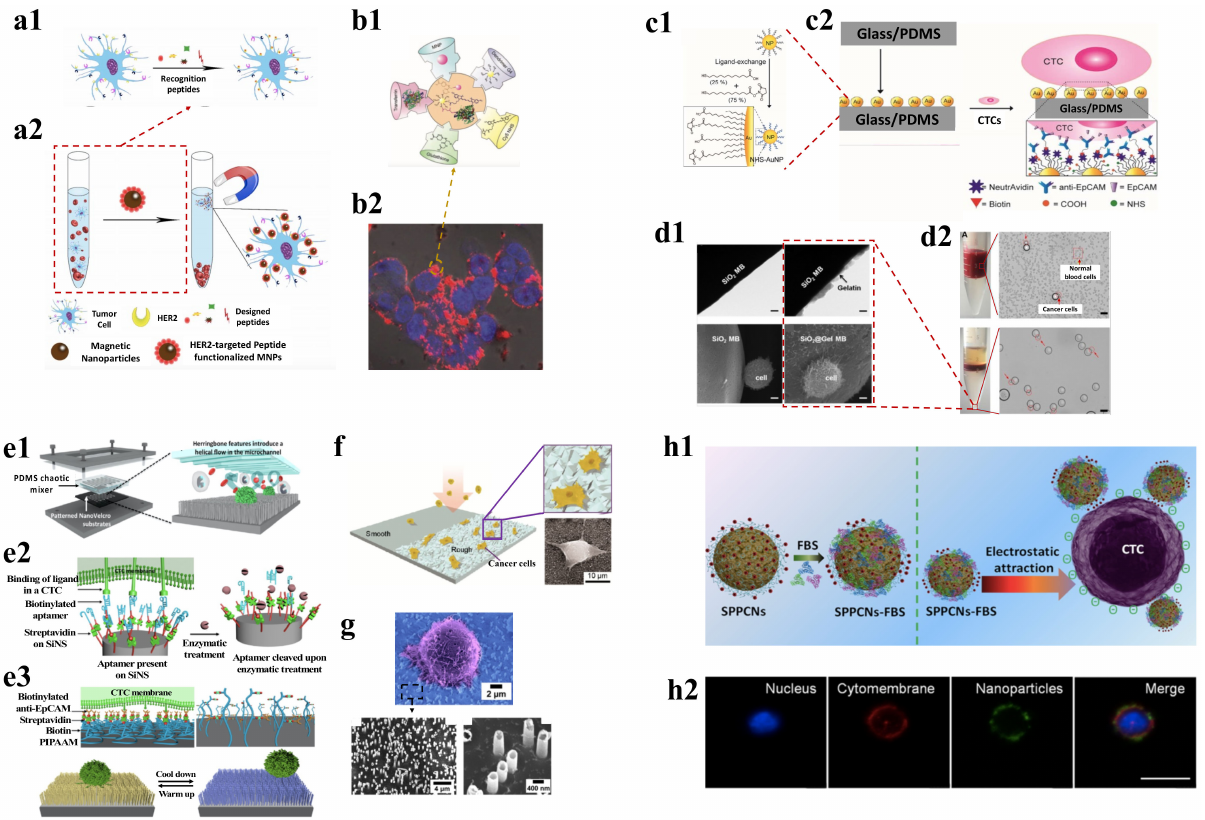
Figure 4. Highlights the different methods for isolation of CTCs using nanoparticles. ( a1 ) Shows the schematic representation of the process that involves tagging ligand conjugated NPs to CTCs. ( a2 ) highlights the capture of the targeted CTCs using an external magnet. Reprinted with permission from [120]. Copyright 2017 American Chemical Society. ( b1 ) shows the different components of the MDNS whereas ( b2 ) demonstrates the effective conjugation of the nanosystem on the surface of the cells (nucleus stained with DAPI appeared blue whereas MDNS appeared as red). Reprinted with permission from [101]. Copyright 2012 John Wiley and Sons. ( c1 ) highlights the preparation of the functionalized NPs by ligand exchange process. ( c2 ) Scheme shows the process of capturing CTCs using AuNPs in Herringbone microfluidic chip. Reprinted with permission from [104]. Copyright 2017 American Chemical Society. ( d1 ) The enlarged SEM image shows the efficient binding of CTCs on the surface of gelatine NPs coated silicon beads separated by Ultra-centrifugation and ( d2 ) represent the microscopic images of the captured cancer by CTC-beads (top panel) and improved selection by density gradient centrifugation (bottom panel); The scale bar is 20 µ m. Reprinted with permission from [106]. Copyright 2018 Ivyspring International Publisher. ( e ) Highlights the different generations of nano-velcro for efficient isolation of CTCs. ( e1 ) represents the first generation in which the Si-nanowire captures the CTCs which flow through the microfluidic device. The second generation of the system as shown in the ( e2 ) panel, is based on enzymatic capture and release of CTCs whereas the third generation (shown in e3 ) uses a thermoresponsive polymer to effectively capture CTCs at 37 ◦ C but releases the cells when the temperature reaches 4 ◦ C. Reprinted with permission from [107]. Copyright 2014 American Chemical Society. ( f ) Shows the nanoroughened glass surface along with the SEM image of cancer cells efficiently captured by it. Reprinted with permission from [122]. Copyright 2013 American Chemical Society. ( g ) Capture of CTCs using nanostraws with the enlarged SEM image of it. Reprinted with permission from [123]. Copyright 2019 American Chemical Society. ( h1 ) shows the process of capturing CTCs by electrically charged NPs, ( h2 ) image panel shows the efficient binding of the positively charged Poly(ethyleneimine)-functionalized Fe 3 O 4 NPs on the outer surface of CTCs due to effect; The scale bar is 20 µ m. Reprinted with permission from [114]. Copyright 2020 American Chemical